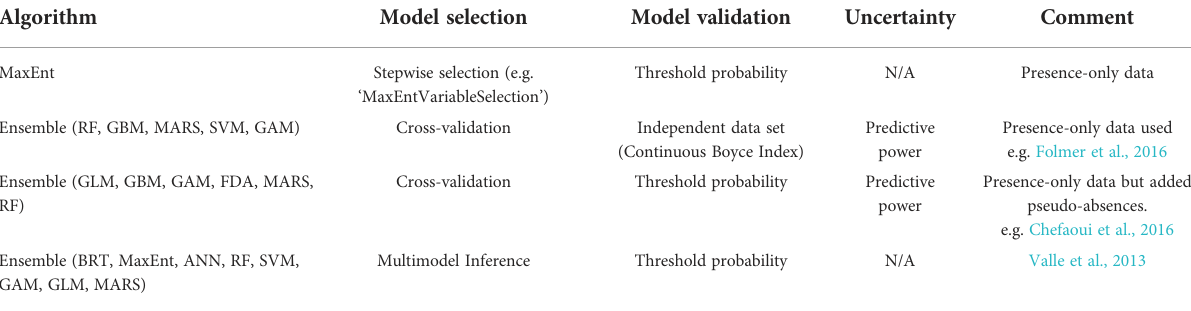
TABLE 1 Model approaches from marine macrophyte studies and recommended model